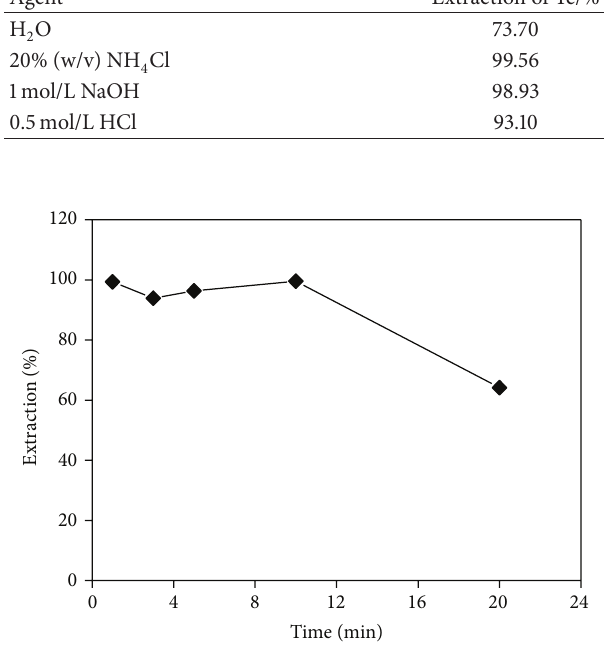
Figure 6: Effect of stripping time on Te(IV) extraction.